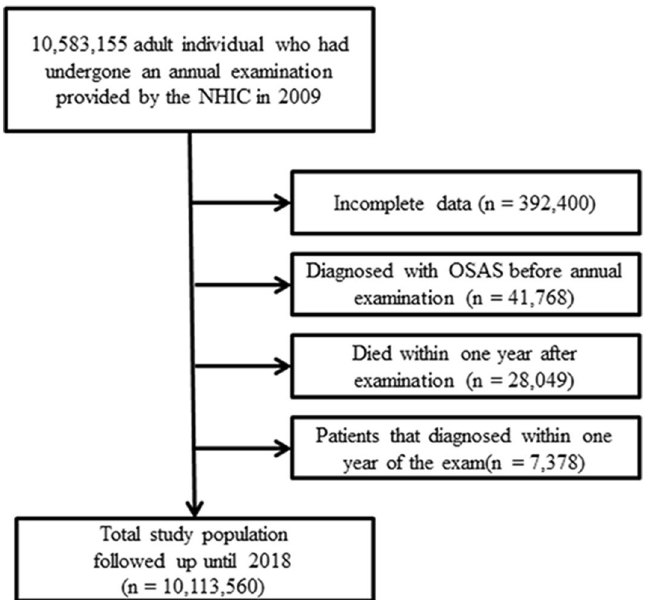
Figure 1. Flow chart of the study